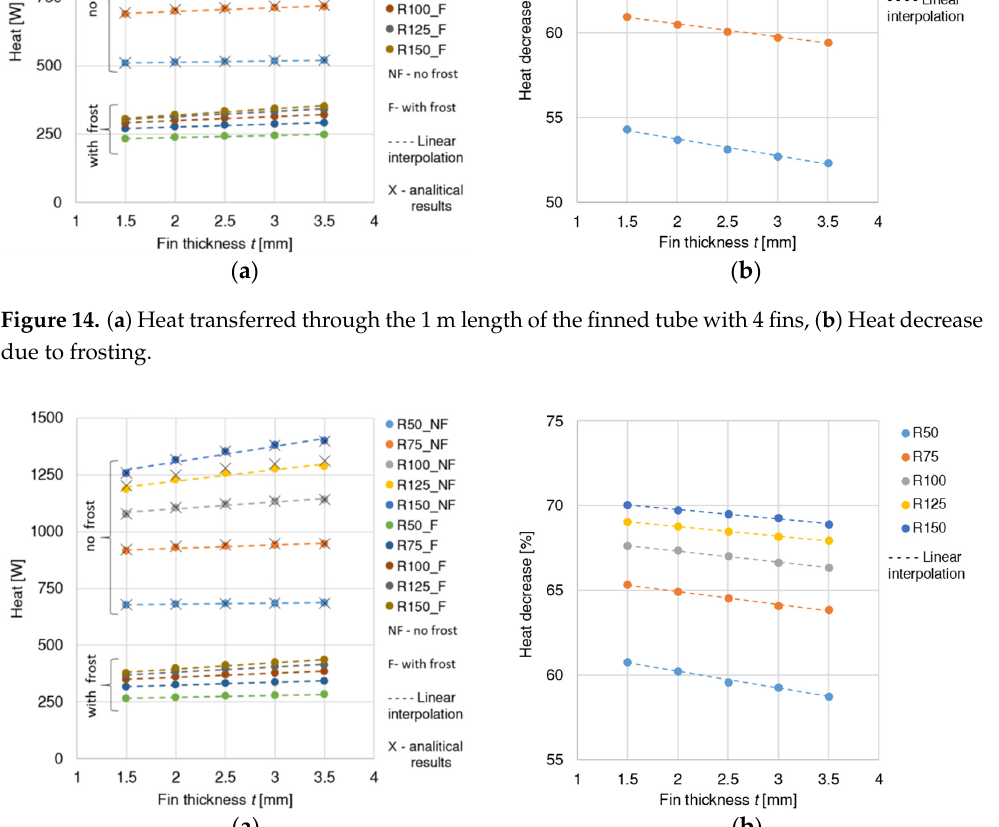
Figure 15. ( a ) Heat transferred through the 1 m length of the finned tube with 6 fins, ( b ) Heat decrease due to frosting.